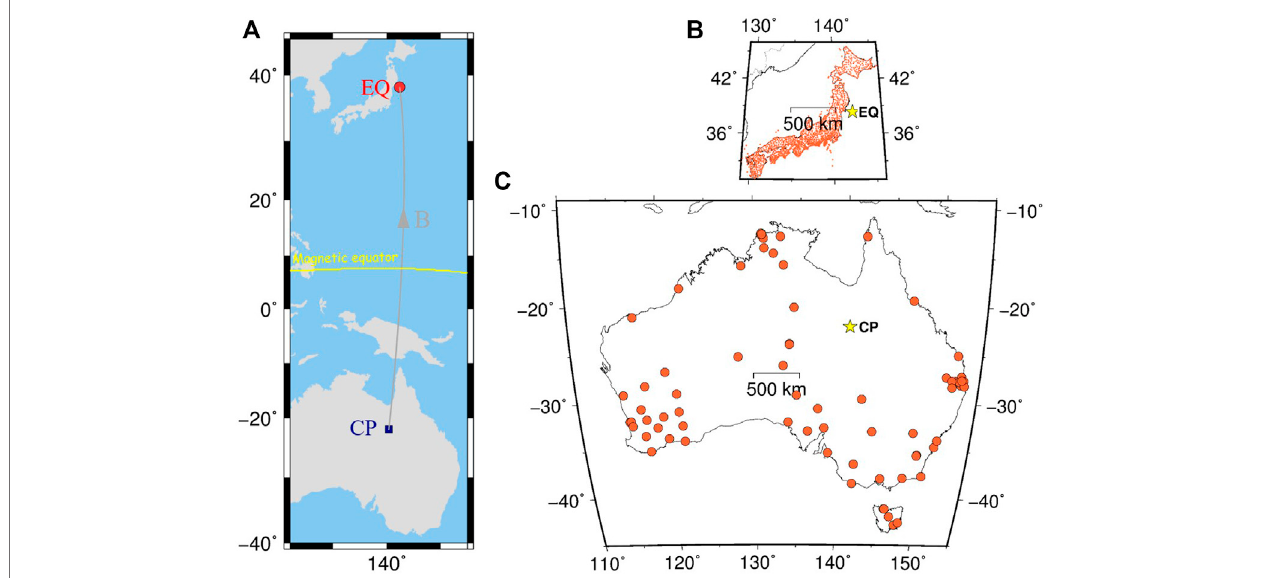
FIGURE1|(A) Themagneticconjugatepoint(CP,bluesquare)oftheepicenter(EQ,redcircle)ofthe2011Tohoku-okiearthquake,Japan,liesinnorthernAustralia (the gray curve indicates the ground projection of the geomagnetic fi eld connecting the two points). The yellow curve denotes the magnetic equator. GNSS stations in Japan (B) andinAustralia (C) weredrawnusingtheHammerequal-areaprojection.In (B) and (C) ,theredcirclesrepresentGNSSstationsandtheyellowstarsshowthe epicenter (B) and its CP (C) .